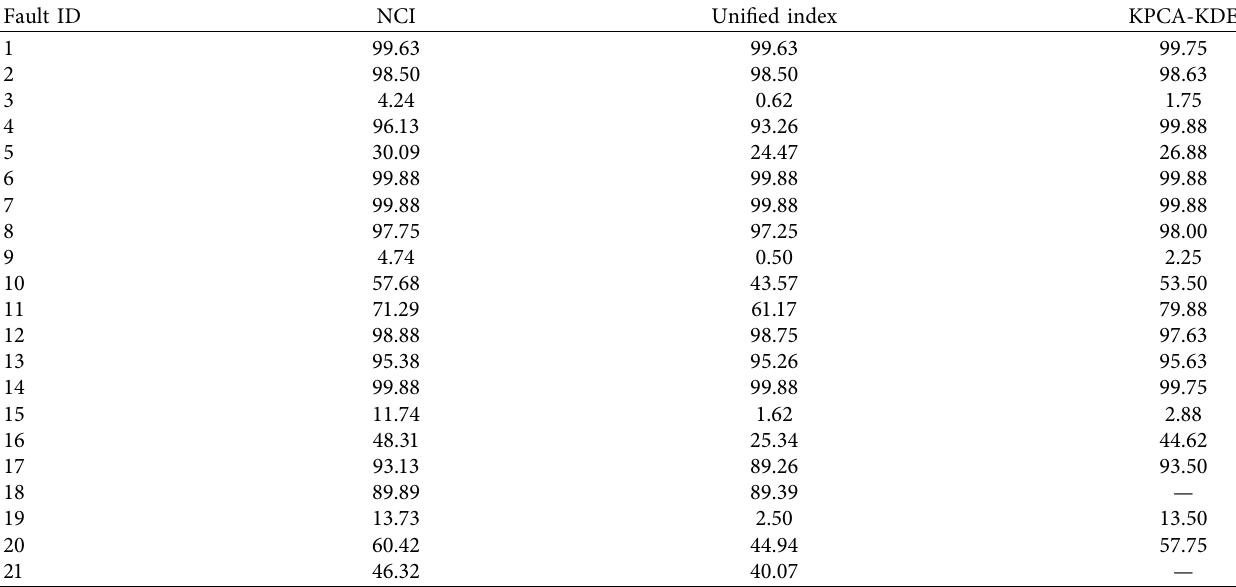
Table 3: Fault detection rate (%) using different